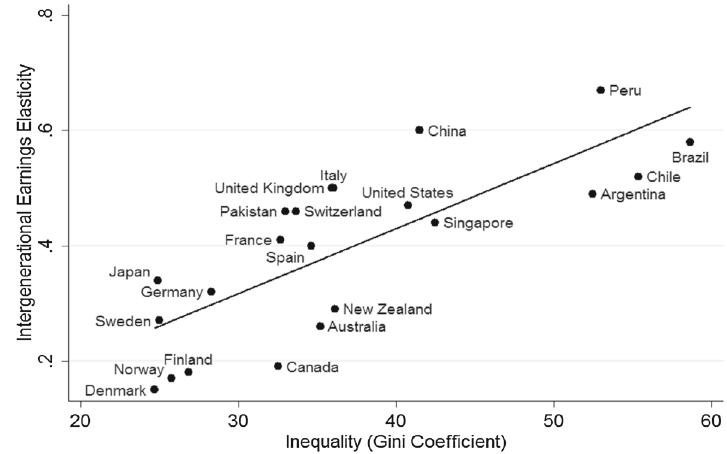
Fig. 2 The “Great Gatsby” curve. (Source: Corak 2013. Data: World